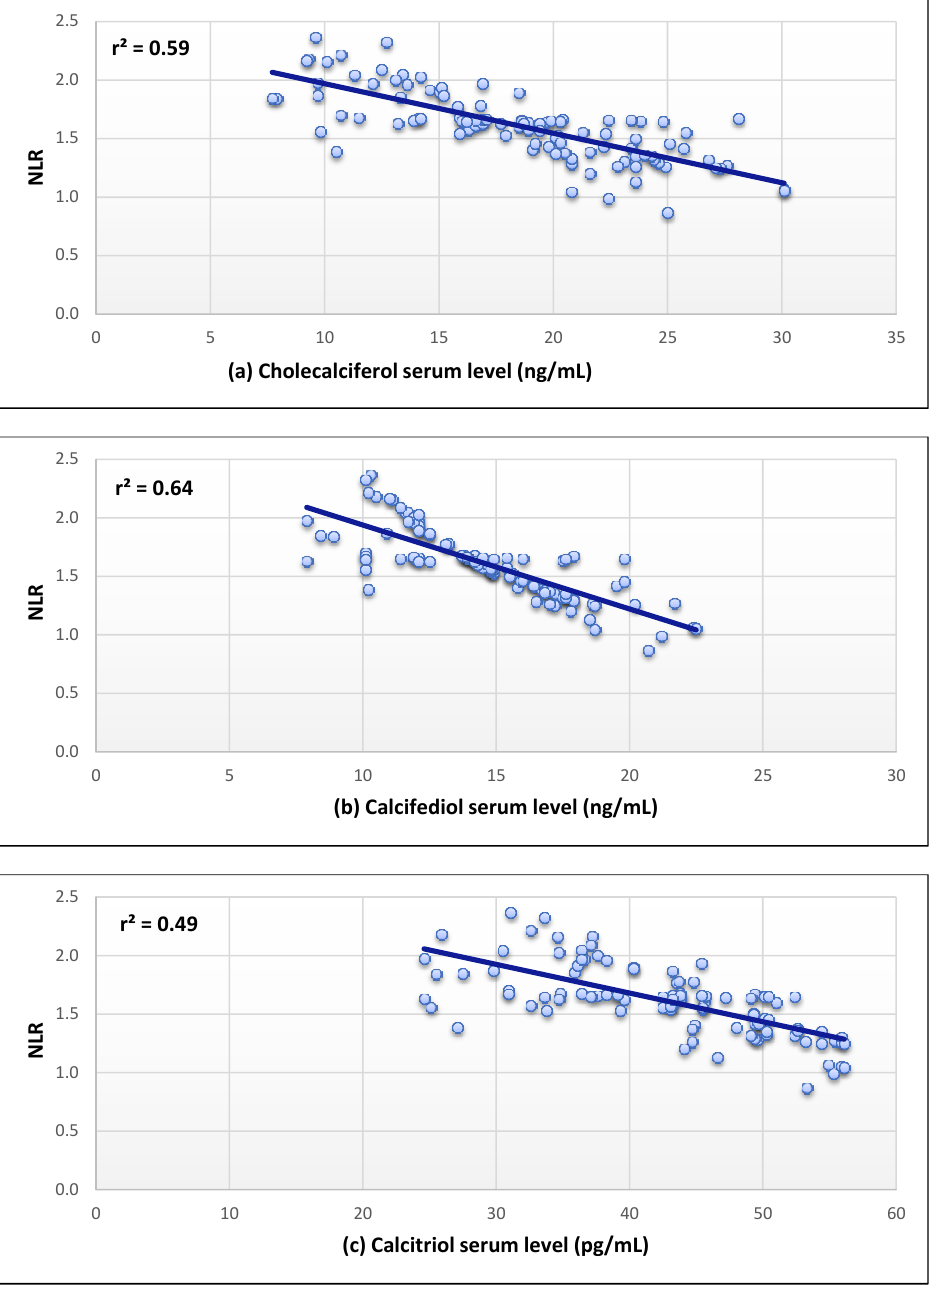
Figure 4. Correlation between the neutrophil-to-lymphocyte ratio (NLR) and ( a – c ) in COVID-19 patients.